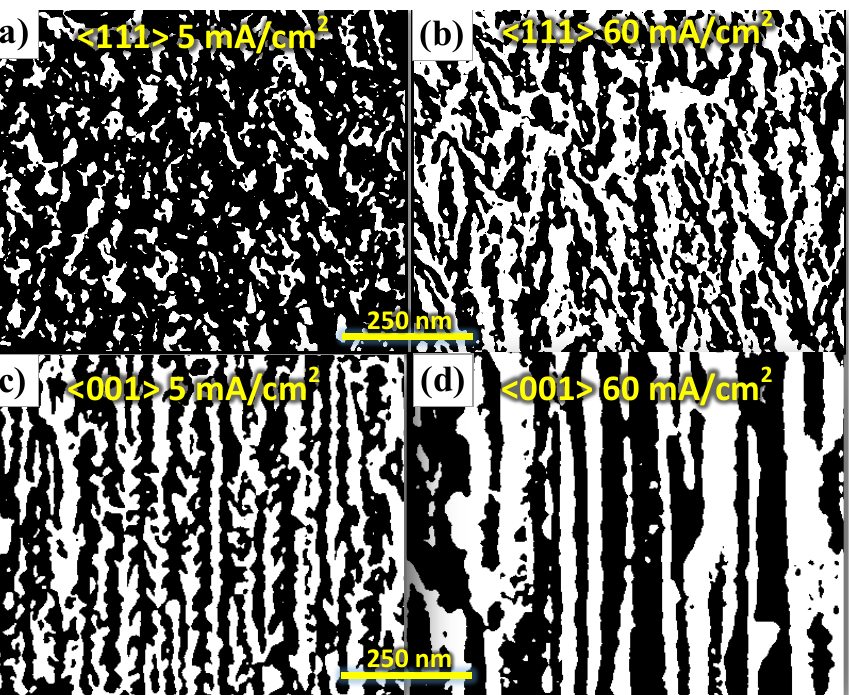
Figure 6. Contrasted SEM images for PSi ( a ) (111) at 5 mA/cm 2 , ( b ) (111) at 60 mA/cm 2 , ( c ) (001) at 5 mA/cm 2 , and ( d ) (001) at 60 mA/cm 2 . SEM images were treated and analyzed with ImageJ software